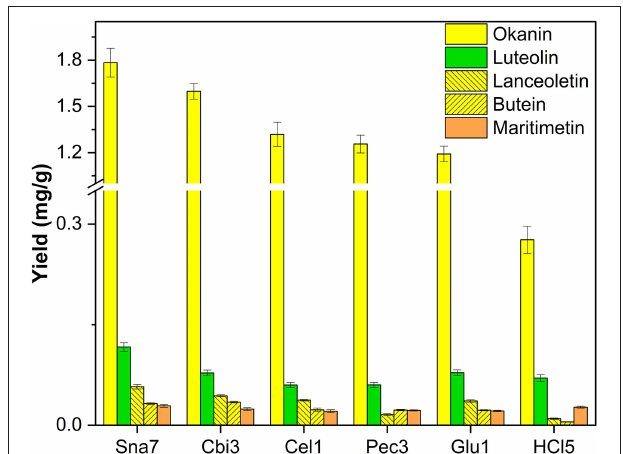
FIGURE 3 | Aglycone yields (mg/g) from flower extracts of B. ferulifolia . Enzymatic hydrolysis (25min): Sna7: 5mg snailase (pH 5.5, 37 ◦ C); Cbi3: 5U cellobiase (pH 4.5, 37 ◦ C); Cel1: 20U cellulase (pH 5.5, 52 ◦ C); Pec3: 20U pectinase (pH 4.5, 40 ◦ C); Glu1: 20U β -glucosidase (pH 4.5, 37 ◦ C). Acidic